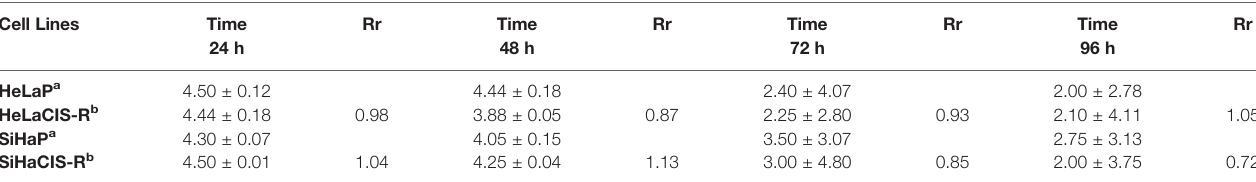
TABLE 2B | IC50 values for PTX (mM) in cervical cancer cells determined by SRB assay. Cell